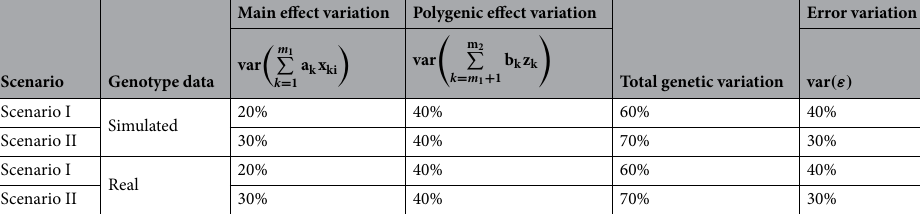
Table 3. Distribution of different genetic variation in the